Question: Write a descriptive caption for this figure.
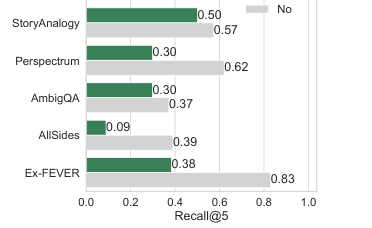
Answer: Retrieval performance (Recall@5) of queries with or with- out perspectives, macro-averaged over all the retrievers.